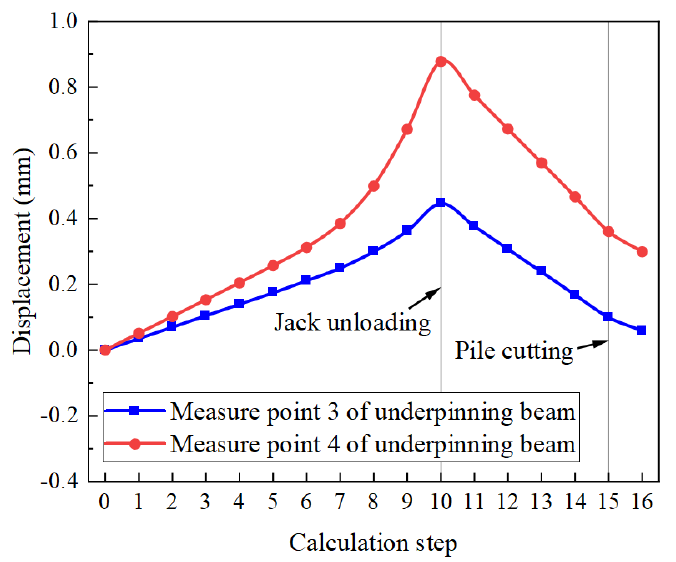
Figure 8. Displacement of the underpinning beam calculated by numerical modelling.